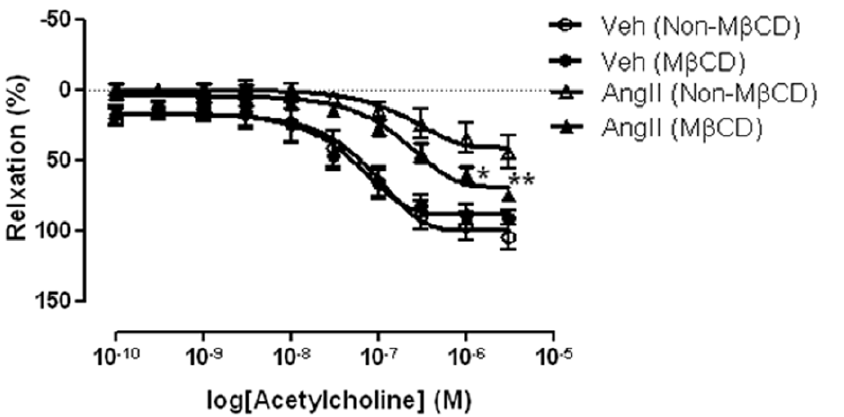
Figure 5. Effects of chemical disruption of caveolae on acetylcholine-induced aortic relaxation. Concentration-response curve of endothelium-dependent relaxation to acetylcholine in aortas of vehicle- and AngII -infused ApoE 2 / 2 mice with or without the presence of methyl- b - cyclodextrin (M b CD) (1 mM). Results are mean 6 SEM and expressed as percentage of relaxation of the submaximal contraction of phenylephrine (1 m M) (n=5); Statistical significance shown as *P , 0.05 and **P , 0.01.